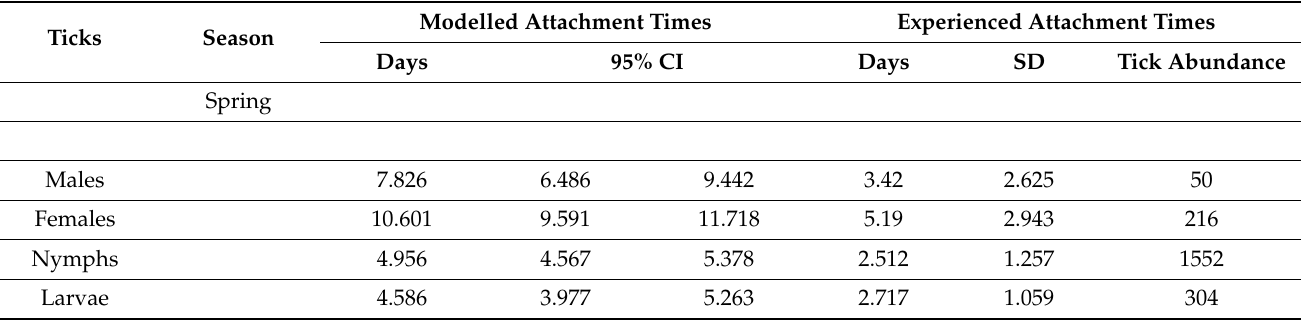
Table 5. Modelled and experienced attachment times of Ixodes ricinus